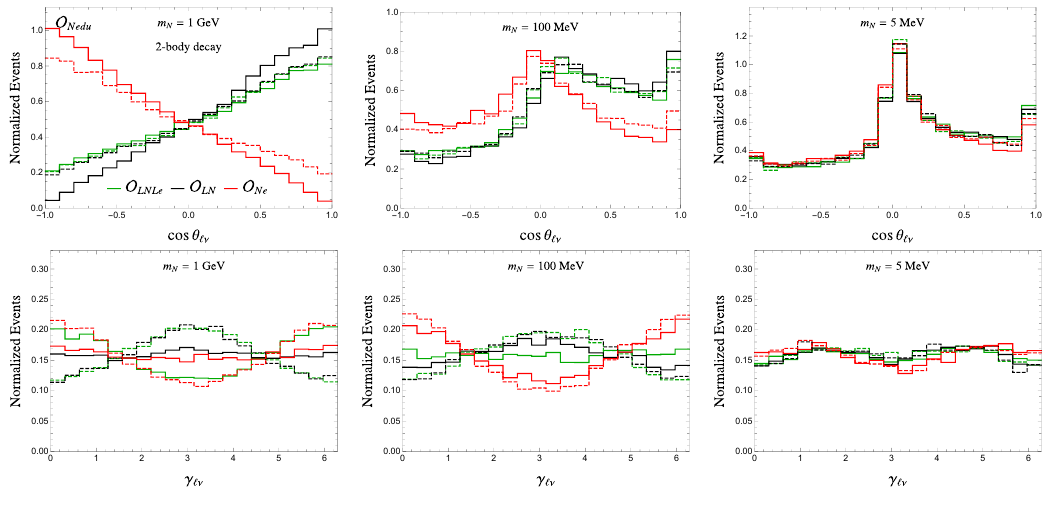
Figure 10 . Same as figure 9, except for angular observables associated with ‘ν